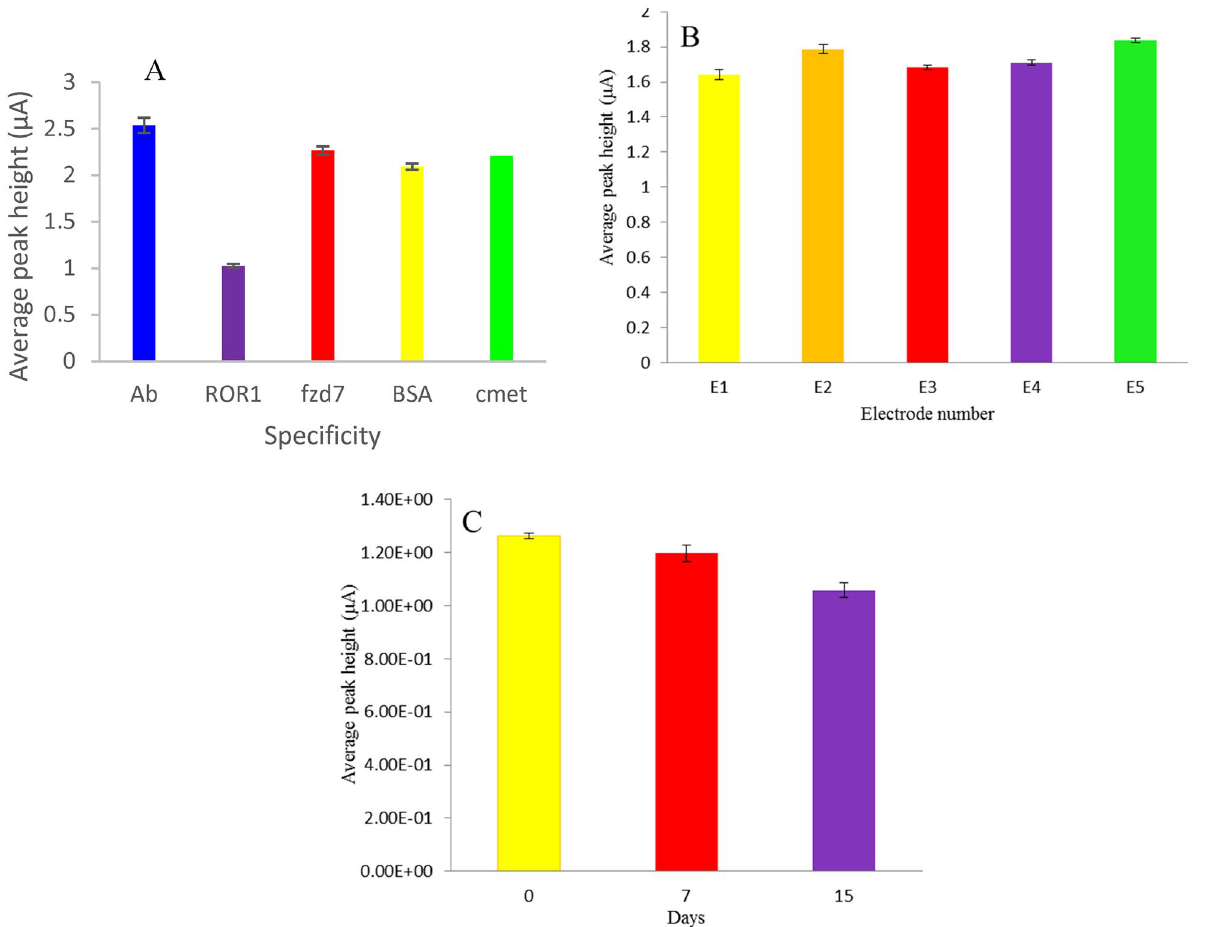
Figure 5. ( A ) Selectivity of immunosensor to ROR1 (1 pg mL −1 ) compared with four nonspecific interferences including cMet (1 pg ml −1 ), fzd7 (1 pg ml −1 ) and BSA (1 pg ml −1 ) (n = 3). ( B ) reproducibility